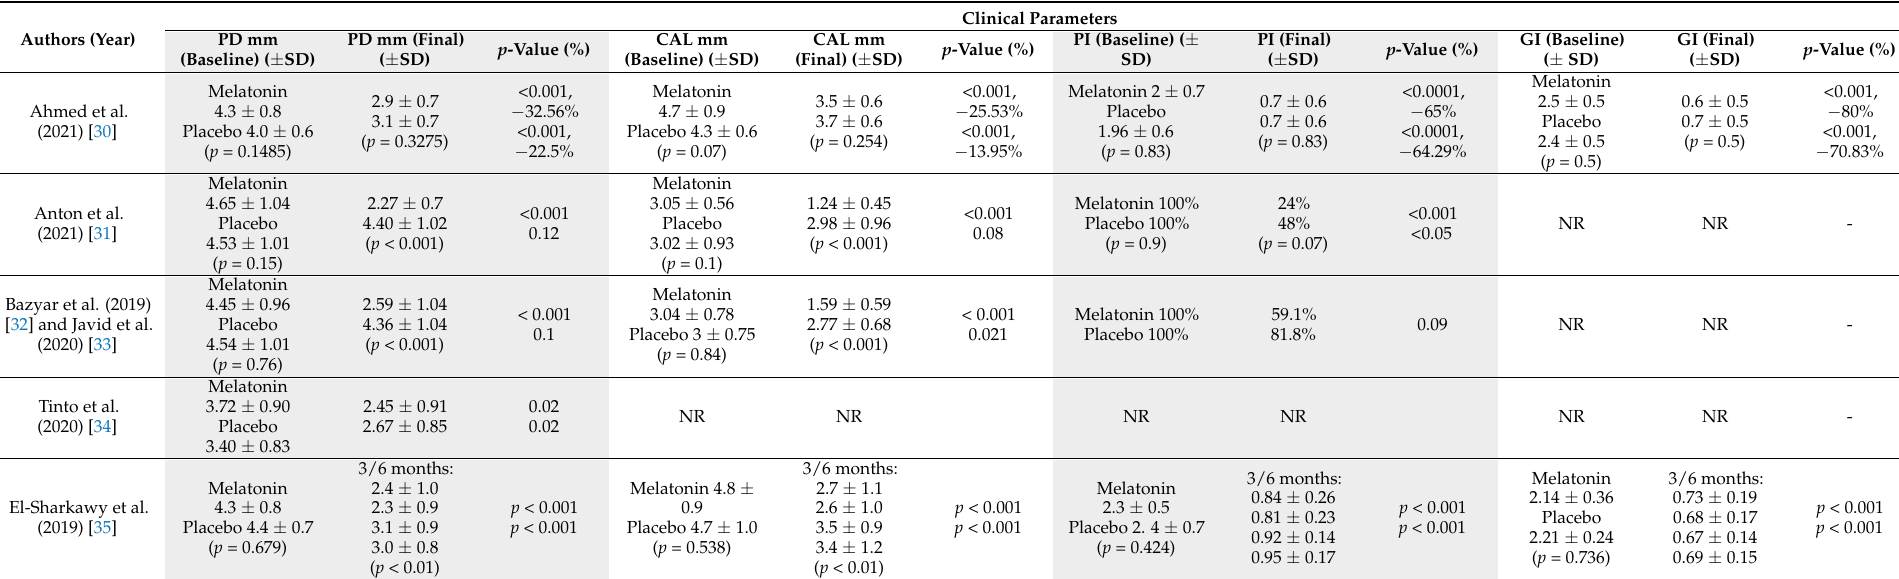
Table 4. Detailed clinical parameters found in the included